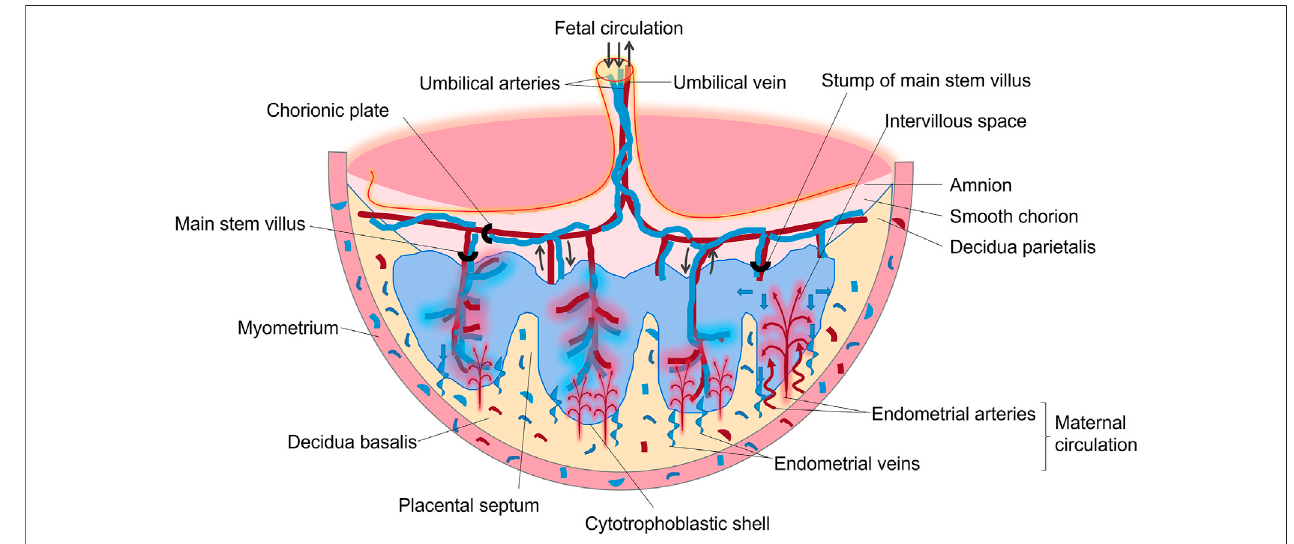
FIGURE 2 | Schematic drawing of a transverse section through a full-term